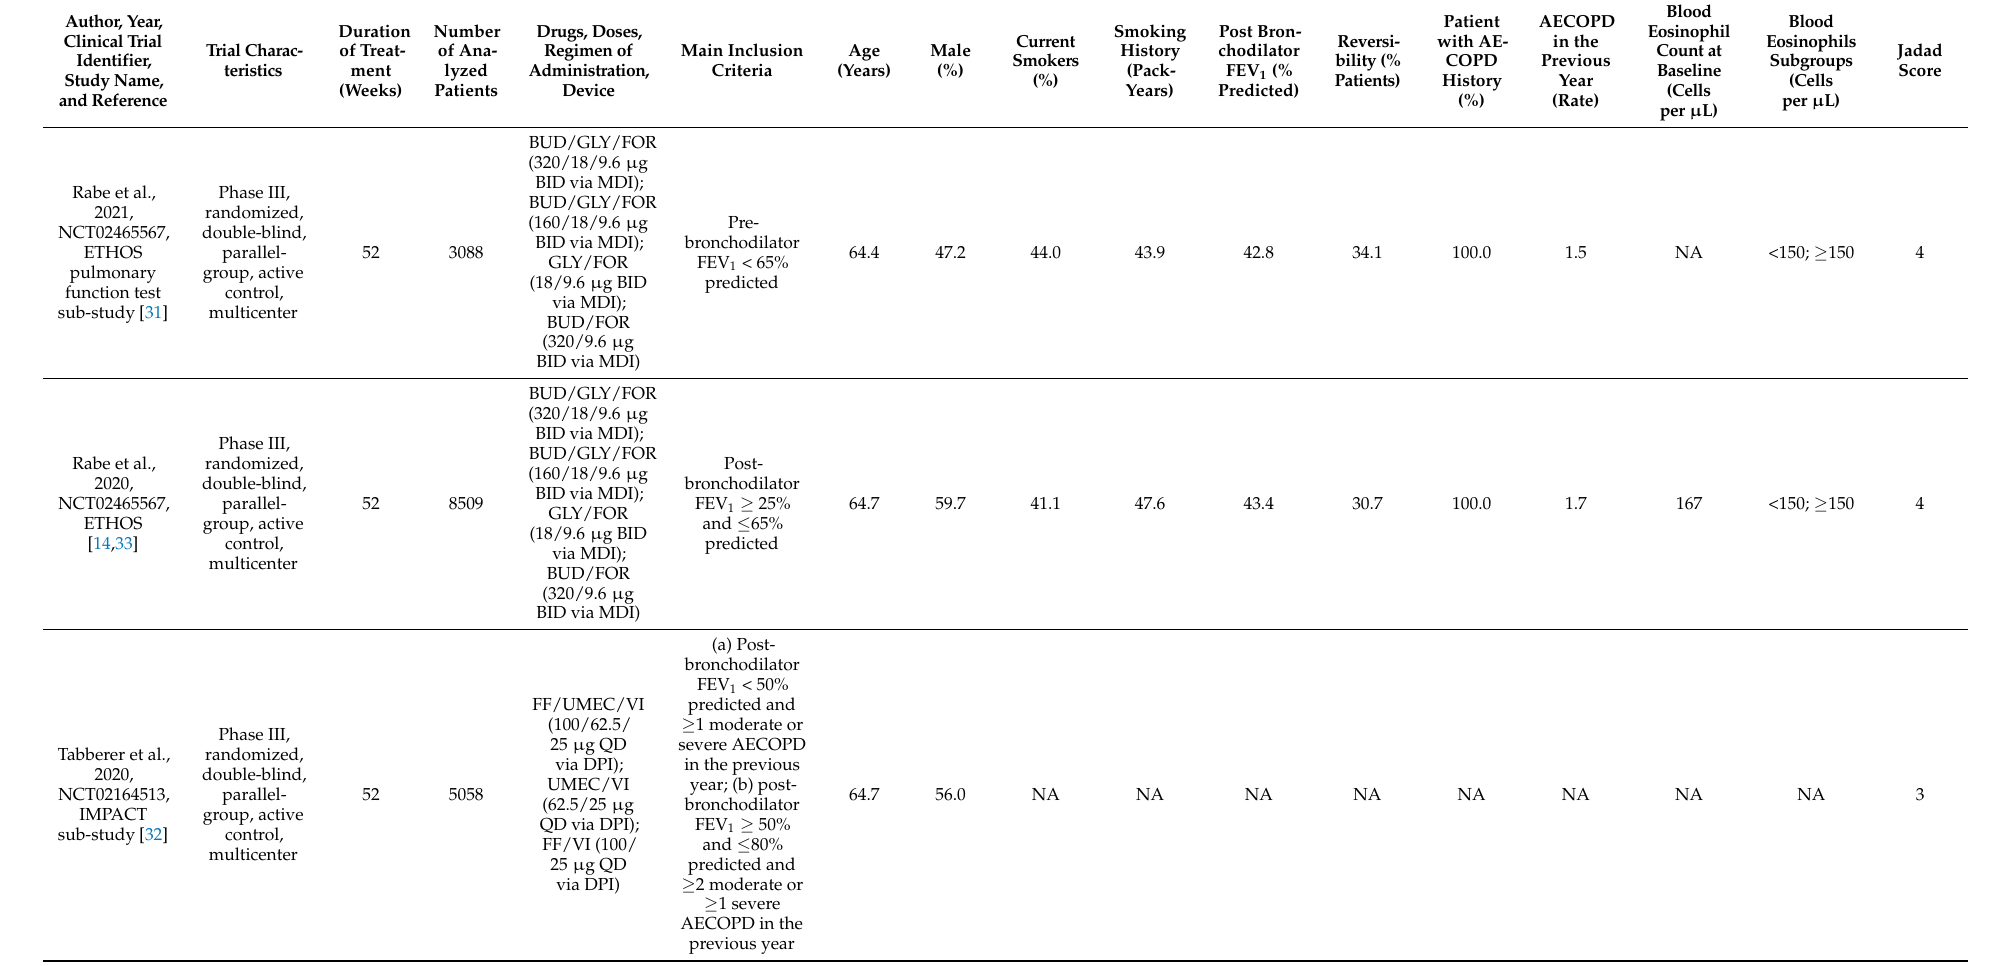
Table 1. Main characteristics of the RCTs included in the network